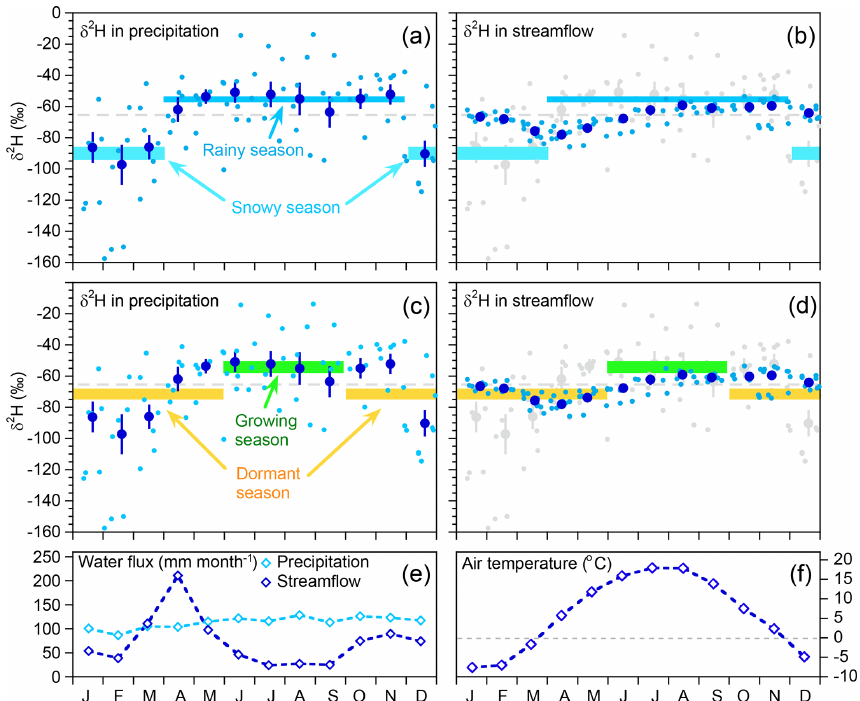
Figure 3. Seasonal variation in deuterium ratios in bulk samples of precipitation (a, c) and grab samples of streamflow (b, d) from 2006 through 2010 at Hubbard Brook Watershed 3. Diamonds in panel (e) are monthly water fluxes averaged over 1958–2014, showing distinct effects of snowmelt in March through May, and evapotranspiration in June through September. Diamonds in panel (f) are monthly mean air temperatures relative to gray reference line of 0 ◦ C. Light blue dots in panels (a–d) show individual samples, with 3 or 4 years of sampling overlapped, depending on month. Dark blue dots show monthly volume-weighted means; error bars show standard errors where these are larger than plotting symbols. Gray dashed line shows the volume-weighted mean for all precipitation. Horizontal bars show seasonal volume- weighted precipitation means ± standard errors, using two different definitions of seasons. (a, b) show seasons defined by the break in isotopic composition between months in which precipitation is predominantly rain (April–November) and predominantly snow (December–March). Defining the seasons in this way maximizes the isotopic difference between them. The next two plots (c, d) show the same underlying isotope measurements, but with averages defined for the growing season (June–September) and the dormant season (October–May). These seasons are isotopically less distinct than the rainy/snowy seasons, because the dormant season overlaps the isotopic shifts between November- December and March–April. The seasonal precipitation means are copied in the right-hand plots (along with the individual precipitation values themselves, in gray), for comparison with the streamflow isotope measurements. Streamflow separation into rainy-season vs. snowy- season precipitation sources is more precise, because these seasonal precipitation sources are more distinct, in comparison to growing-season vs. dormant-season precipitation